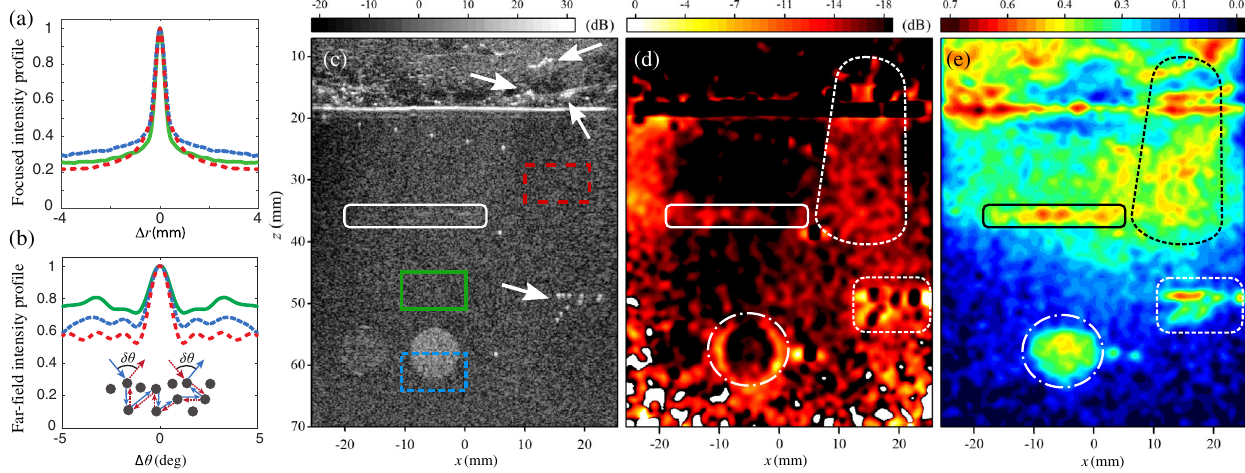
ð r ; Δ x Þ and (b) the far av